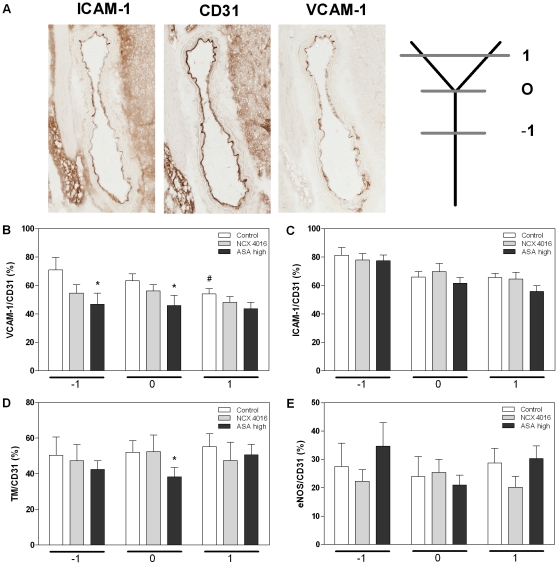
Immunohistochemical stainings of inflammatory and thrombotic markers.A) VCAM-1 and ICAM-1 expression of carotid arteries with adjacent CD31 staining. Expression levels of VCAM-1 (B), ICAM-1 (C), thrombomodulin (D) and eNOS (E) in endothelial cells of carotid arteries of irradiated ApoE−/− treated with control chow, NCX 4016 (60 mg/kg/day) or high dose ASA (300 mg/kg/day) containing chow. Bar graphs show the mean expression levels at three positions in the carotid artery: −1; below the bifurcation, 0; at the bifurcation, 1; above the bifurcation and are corrected for the percentage of intact endothelium detected with CD31. Data represents group means ± SEM (n = 10) * Indicates significant differences between high dose ASA and control chow at the same position and # indicates significant difference between position -1 and 1(p<0.05 by Mann-Whitney U test).